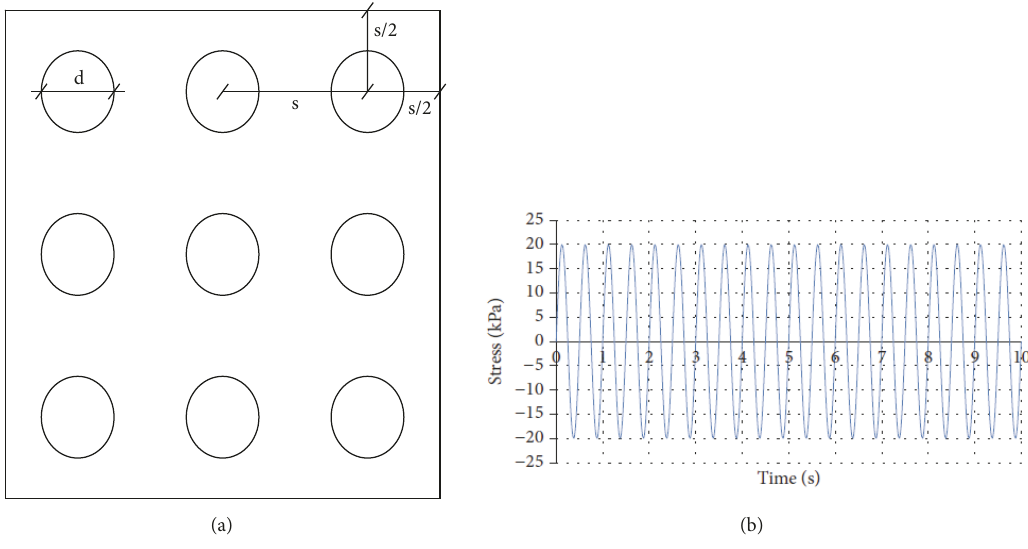
Figure 1: (a) 9-pile foundation diagram and (b) affected dynamic load